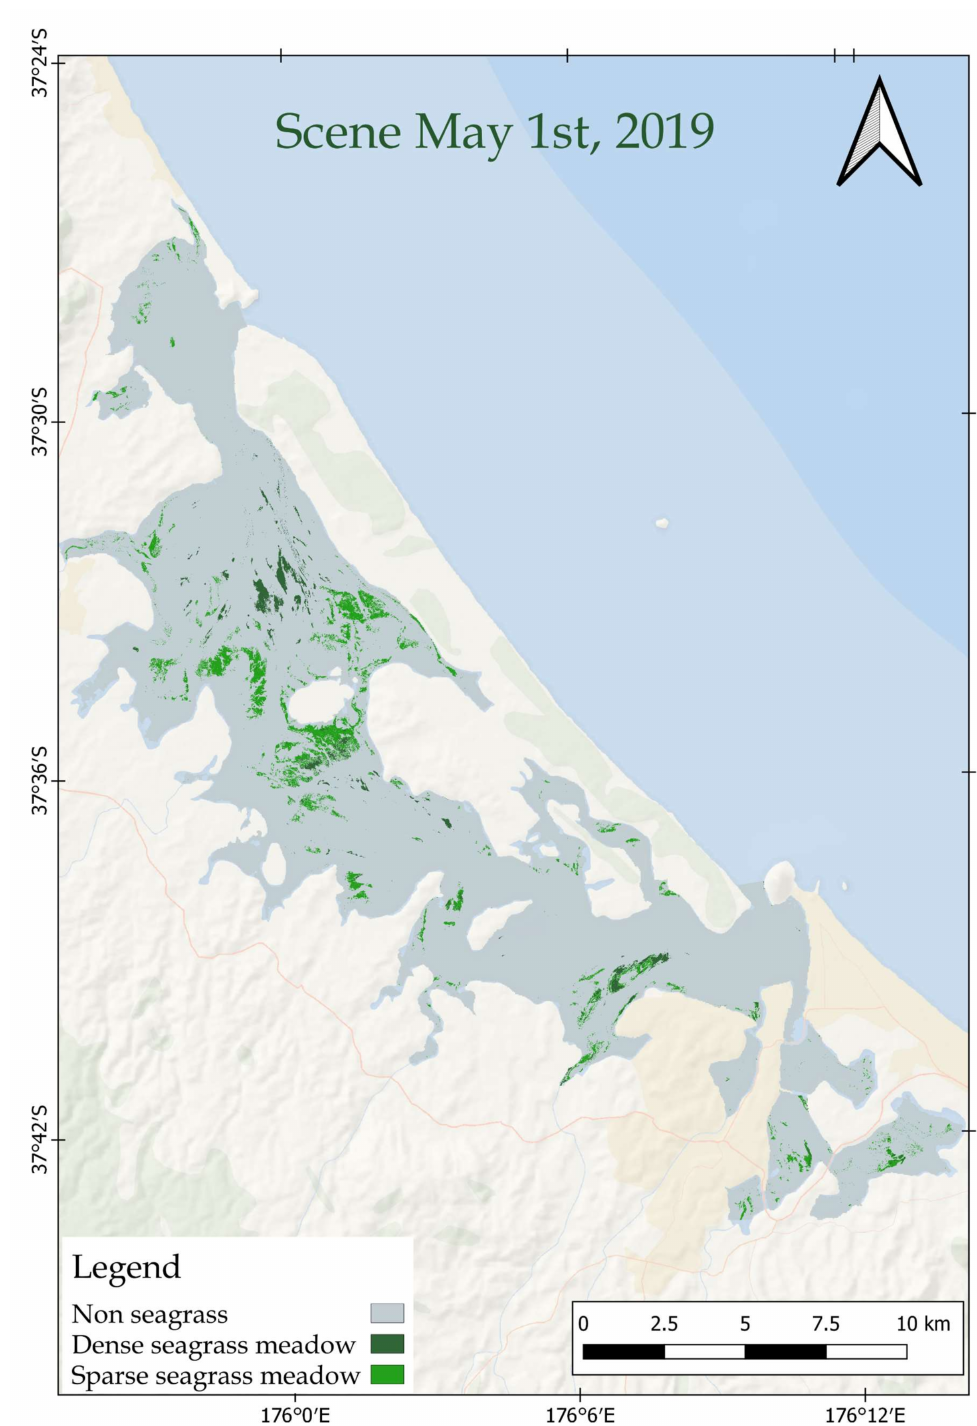
Figure 5. Seagrass map for Tauranga Harbor, 1 May 2019, derived using the RoF model applied to Sentinel-2